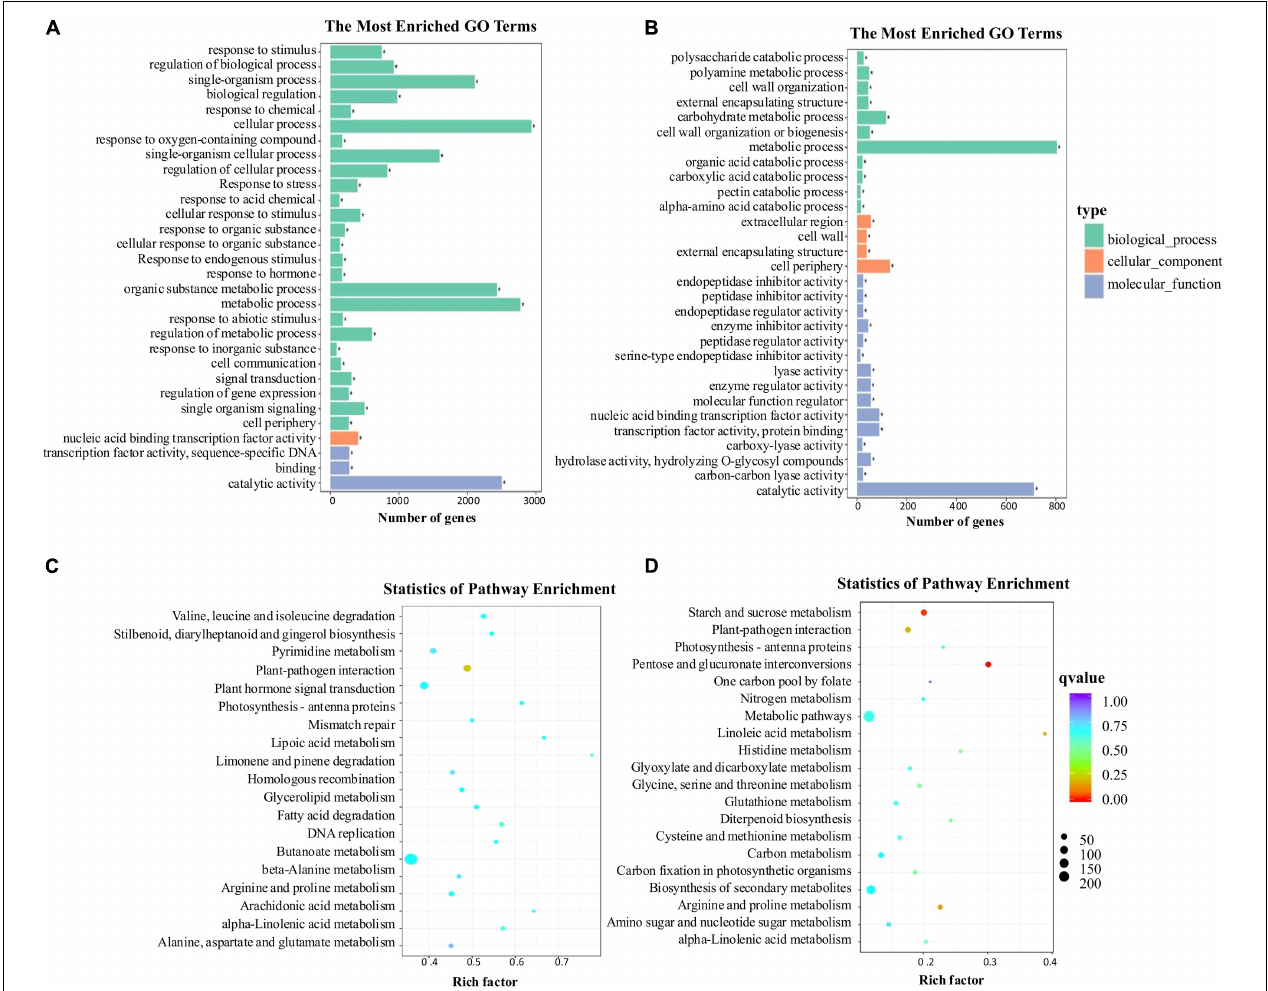
FIGURE 6 | Functional categorization with the DEGs (differentially expressed genes). (A) GO analysis was performed with the DEGs at − 2 DAA (days after anthesis). (B) GO analysis was performed with the DEGs at 0 DAA. (C) KEGG analysis was performed with the DEGs at − 2 DAA. (D) KEGG analysis was performed with the DEGs at 0